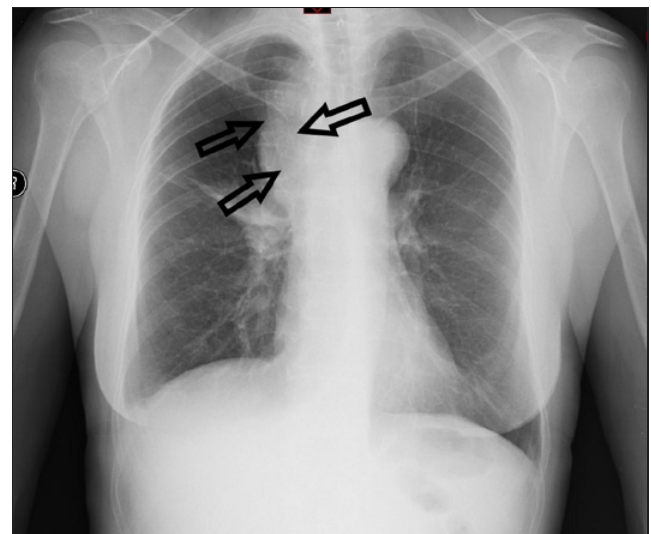
Figure 3. Chest X-ray: Intravascular stent in the projection of